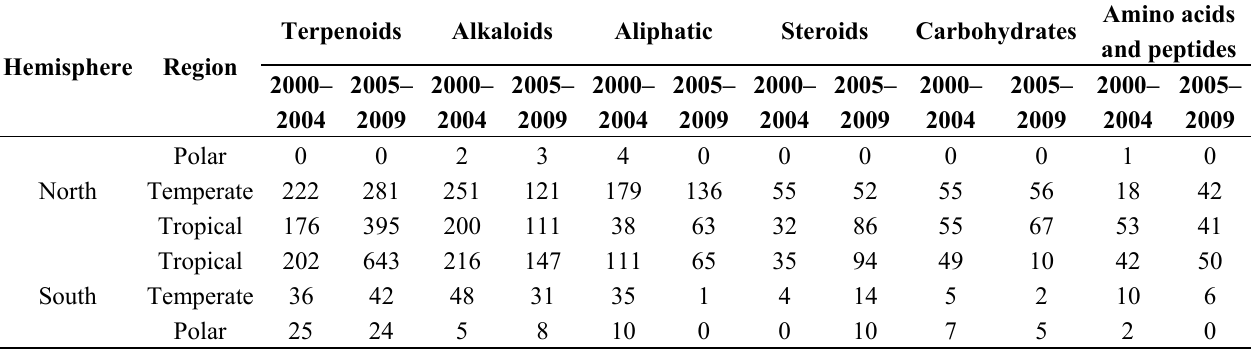
Table 2. Number of new marine natural products from invertebrates discovered during the first (2000–2004) and second half (2005–2009) of the first decade of the twenty first century according to chemical groups and latitudinal regions where target organisms were